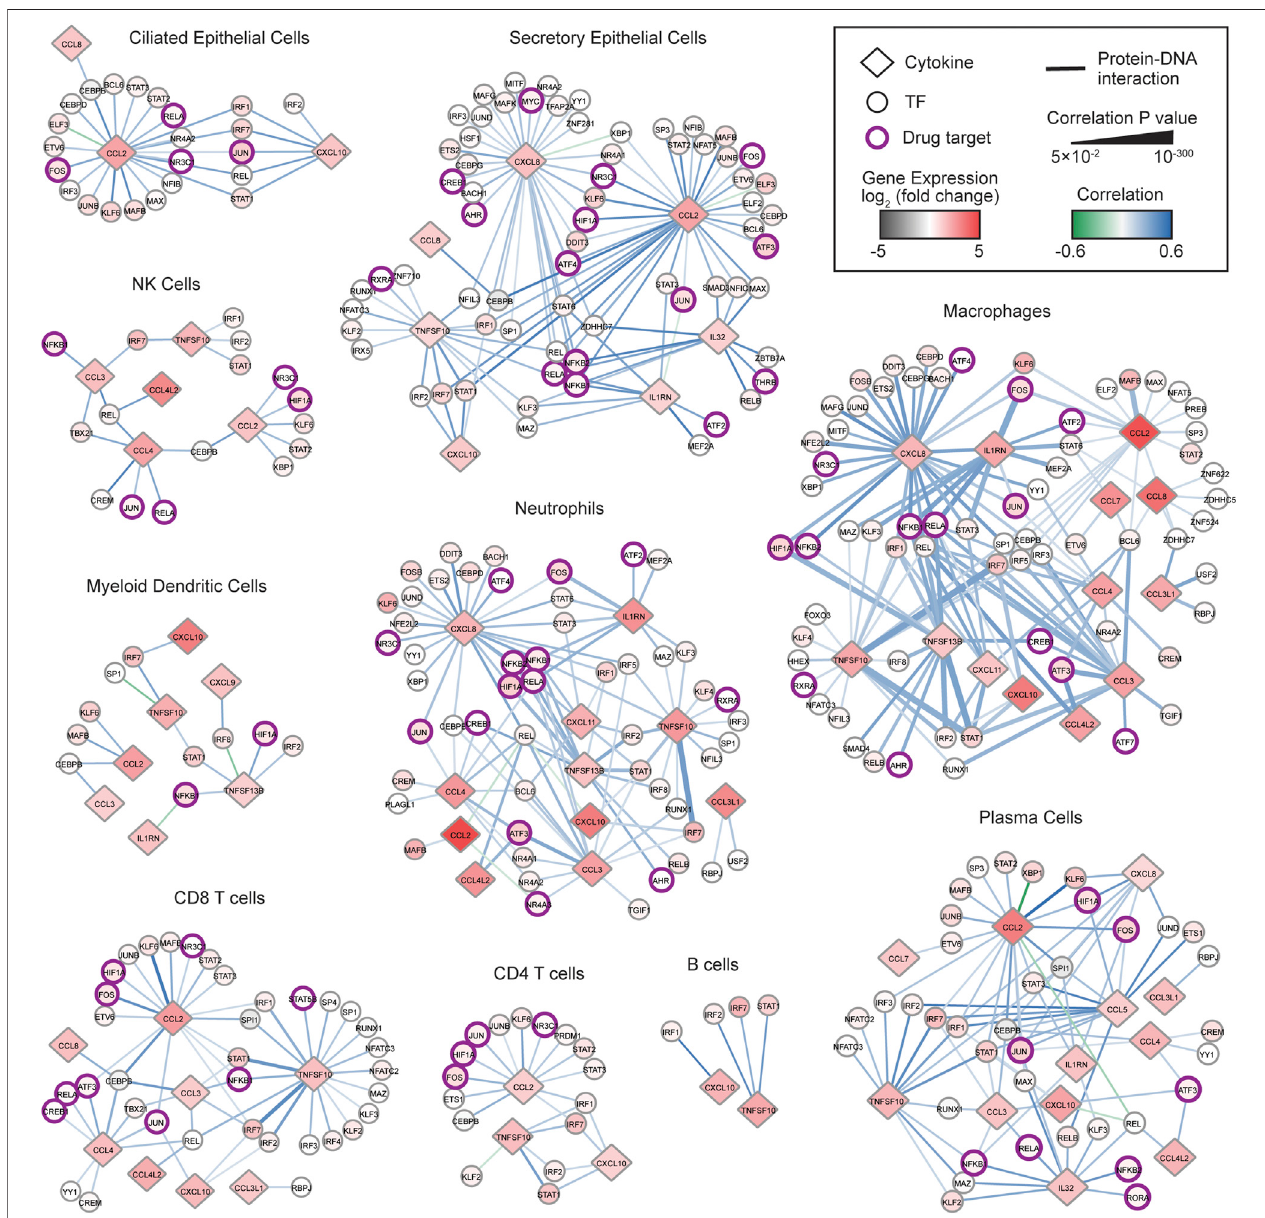
FIGURE 1 | COVID-19 cytokine gene regulatory network. Immune cell sub-networks mapping 581 TF-cytokine gene interactions between 95 TFs and 16 cytokine genes upregulated in BALFs of COVID-19 patients. Networks were restricted to interactions that are signi fi cantly correlated (Padj < 0.05) with a Pearson correlation coef fi cient > 0.1 or < − 0.1 in the respective immune cell subtype. Diamonds represent cytokines and circles represent TFs. TFs that are targets of FDA approved drugs are indicated in purple circles. The node color denotes the differential gene expression of TFs and cytokines in the respective immune cell subtype from BALFs of COVID-19 patients compared to healthy controls. The edge color denotes the Pearson correlation coef fi cient, and the edge thickness is proportional to the correlation adjusted p value.